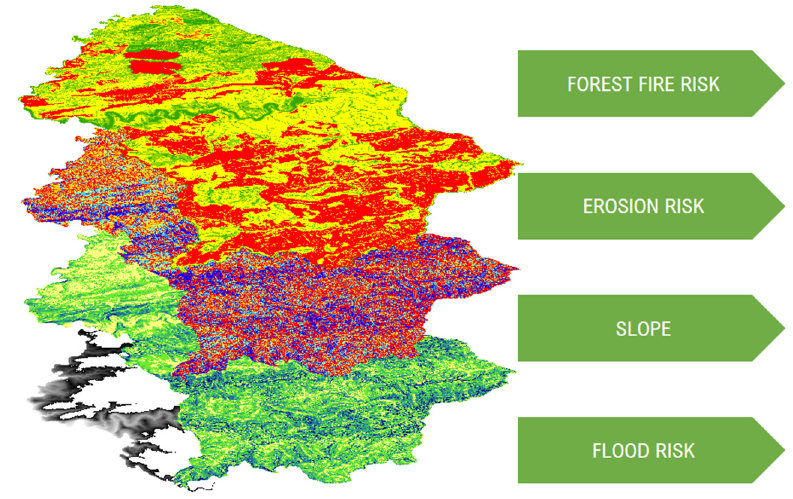
Figure 8. Multi-criteria factors.